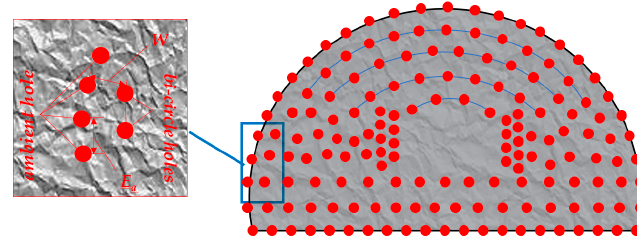
Figure 3. SWB design parameters.